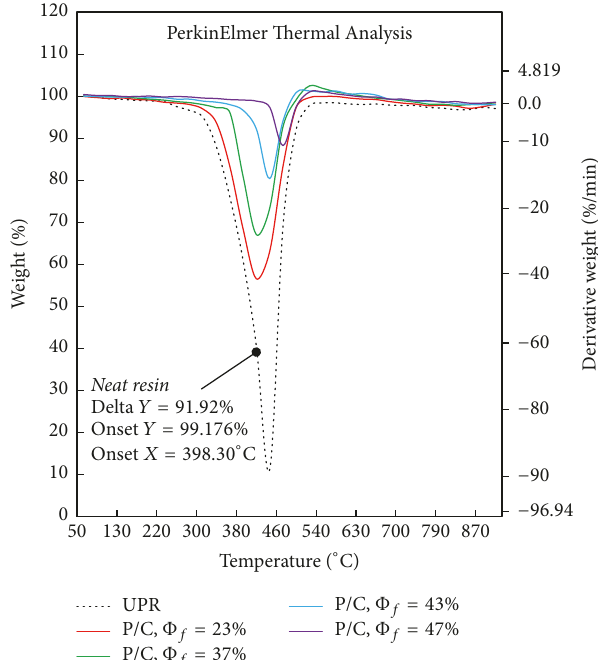
Figure 6: DTA curves of P/C composites as various amounts of Cu